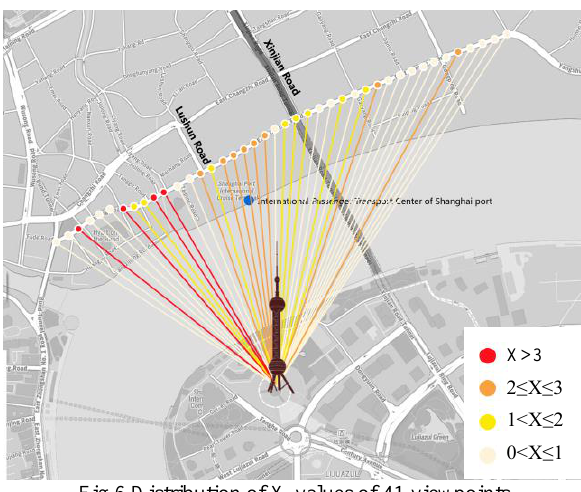
Fig.6 Distribution of X-values of 41